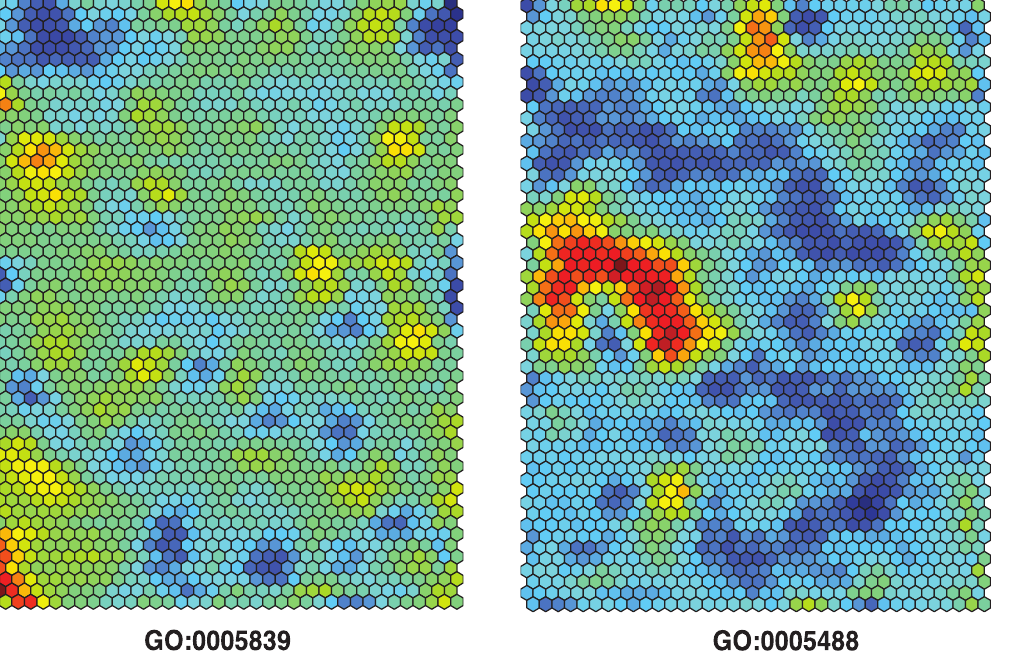
Figure 2. SOM GI50 projection of H-scores for the GO:proteasome pathway (GO:0005839, left panel) and the GO:binding pathway (GO:0005488, right panel). The SOM GI50 is represented as a 2 dimensional map of 54 rows by 37 columns, corresponding to 1998 clusters. Pathway H-scores are projected spectrally on the SOM GI50 (red: best H-score, blue: worst H-score). The lower left region of the leftmost GI50 SOM has the cluster containing camptothecin (CPT). This corresponds to the node with the highest H-score for the GO:proteasome pathway. The GO:binding pathway consists of genes associated primarily with organic acid transport, particularly into the mitochondrion. The majority of NCI60 screened compounds associated with the GO:0005488 SOM GI50 nodes having the highest H-scores contain multiple carboxylate groups.